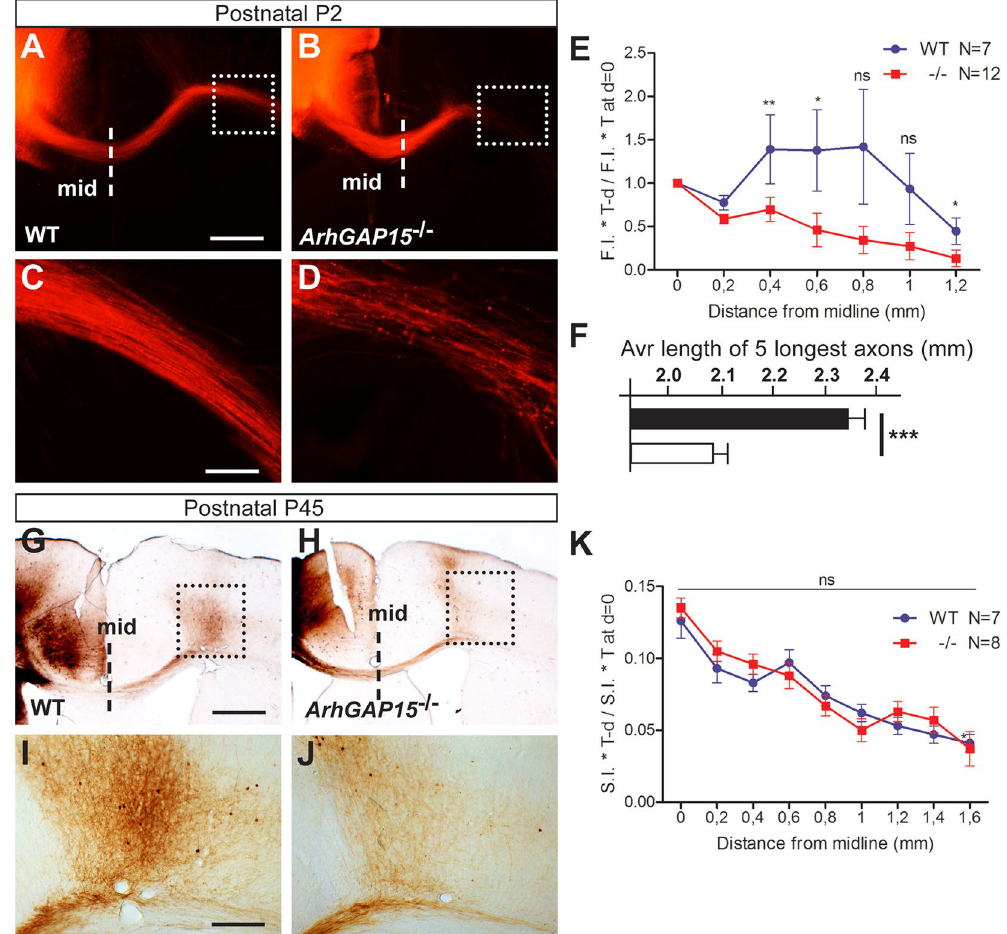
Figure 4. Loss of ArhGAP15 affects the length and targeting of pyramidal callosal commissural axons in vivo . ( A – D ) Representative images of DiI-labeled callosal projection of WT ( A , C ) and ArhGAP15 − / − ( B , D ) P2 brains, for tracing analyses. Low magnification images are shown on the top, while the box inserts indicate the area shown at a higher magnification, on the bottom. ( E ) Quantification of the F.I. * thickness of the callosal bundle, normalized against the F.I. * thickness at the midline (indicated in panels A and B with dashed lines), as a function of the distance from the midline. 7 and 12 sections were examined for, respectively, the WT and ArhGAP15 mutant genotypes, from at least 3 independent brains in both cases. ( F ) Average length from the midline, in mm, of the 5 longest DiI-labelled callosal axons, in WT (solid bars, N = 7) or ArhGAP15 − / − (open bars, N = 12) brain slices. ( G – J ) Representative images of BDA-labeled callosal projections of WT ( G , I ) and ArhGAP15 − / − ( H , J ) P45 brains, for tracing analyses. Images on the top are at low magnification, to show the injection site, the callosal projections, and the midline (reported in panels G and H with dashed lines). Images on the bottom are higher magnification of the inset indicated in the images on the top. Scale bars in A and G = 200 μ m, bars in C and I = 20 μ m. ( K ) Quantification of axonal length, as in panel E except that F.I. was substituted with S.I. (staining intensity). No difference was observed at this age. 7 and 8 comparable sections of the WT and ArhGAP15 − / − animals were examined, respectively, deriving from 3 brains of each genotype. Data are presented as mean ± SEM. * P ≤ 0.05, ** P ≤ 0.01 (Mann-Whitney